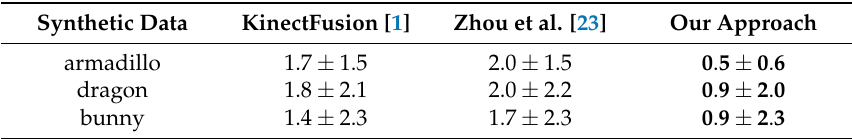
Table 5. Reversed C2M error in millimeters on our synthetic